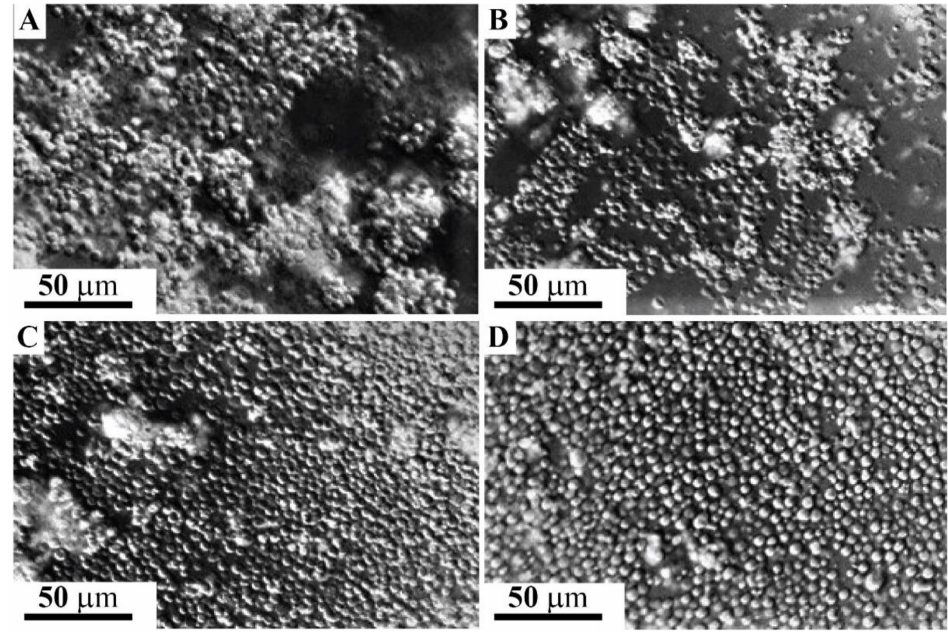
Figure 5. Hatched blastula cell reaggregation. ( A ) promotion of sea urchin hatched blastula cell aggregation by 15 µ g of the g580 glycan in the volume of 100 µ L FSW containing 10 5 cells was performed using gentle rotation at 16 ◦ C for 10 min, ( B ) aggregation promotion by 15 µ g of the sponge g200 glycan under the same condition as in ( A ), ( C ) not treated culture of 105 dissociated hatched blastula cells, and ( D ) inhibition of sea urchin hatched blastula cell reaggregation by 15 µ g of the anti-GN1 Fab fragments of the Block 2 monoclonal antibody was performed as in ( A , B ), but for 1